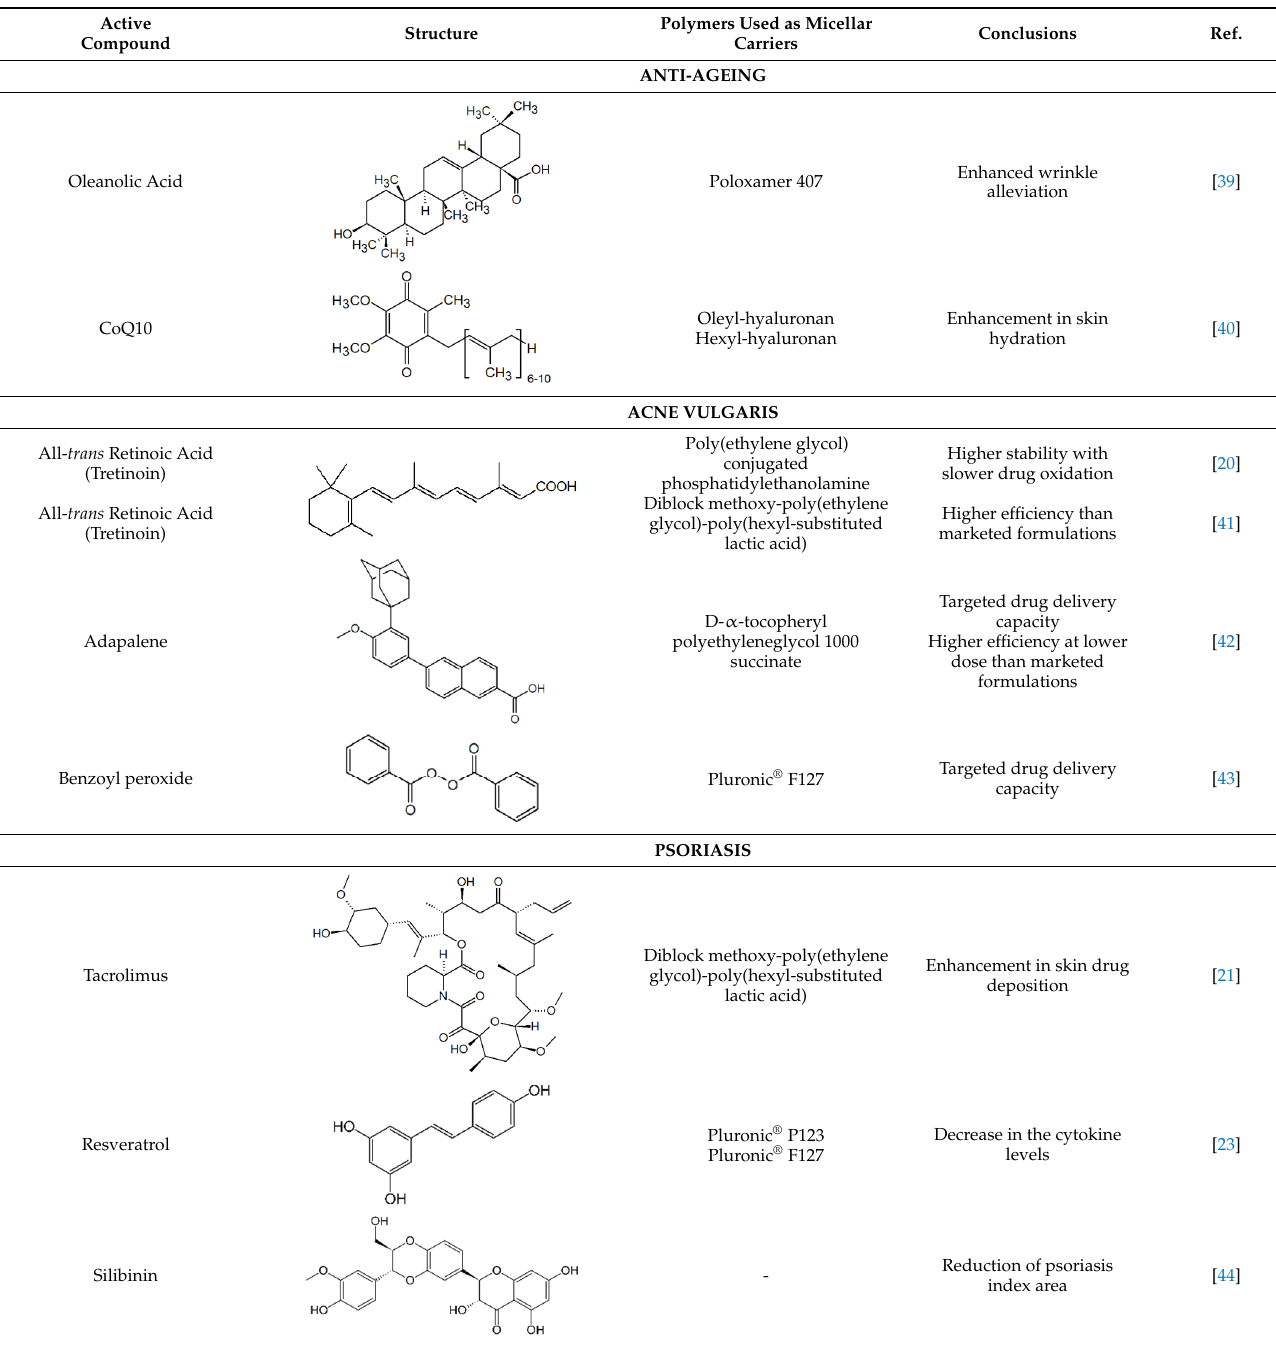
Table 1. Polymer micelles prepared for skin delivery described in the literature in the last decade.